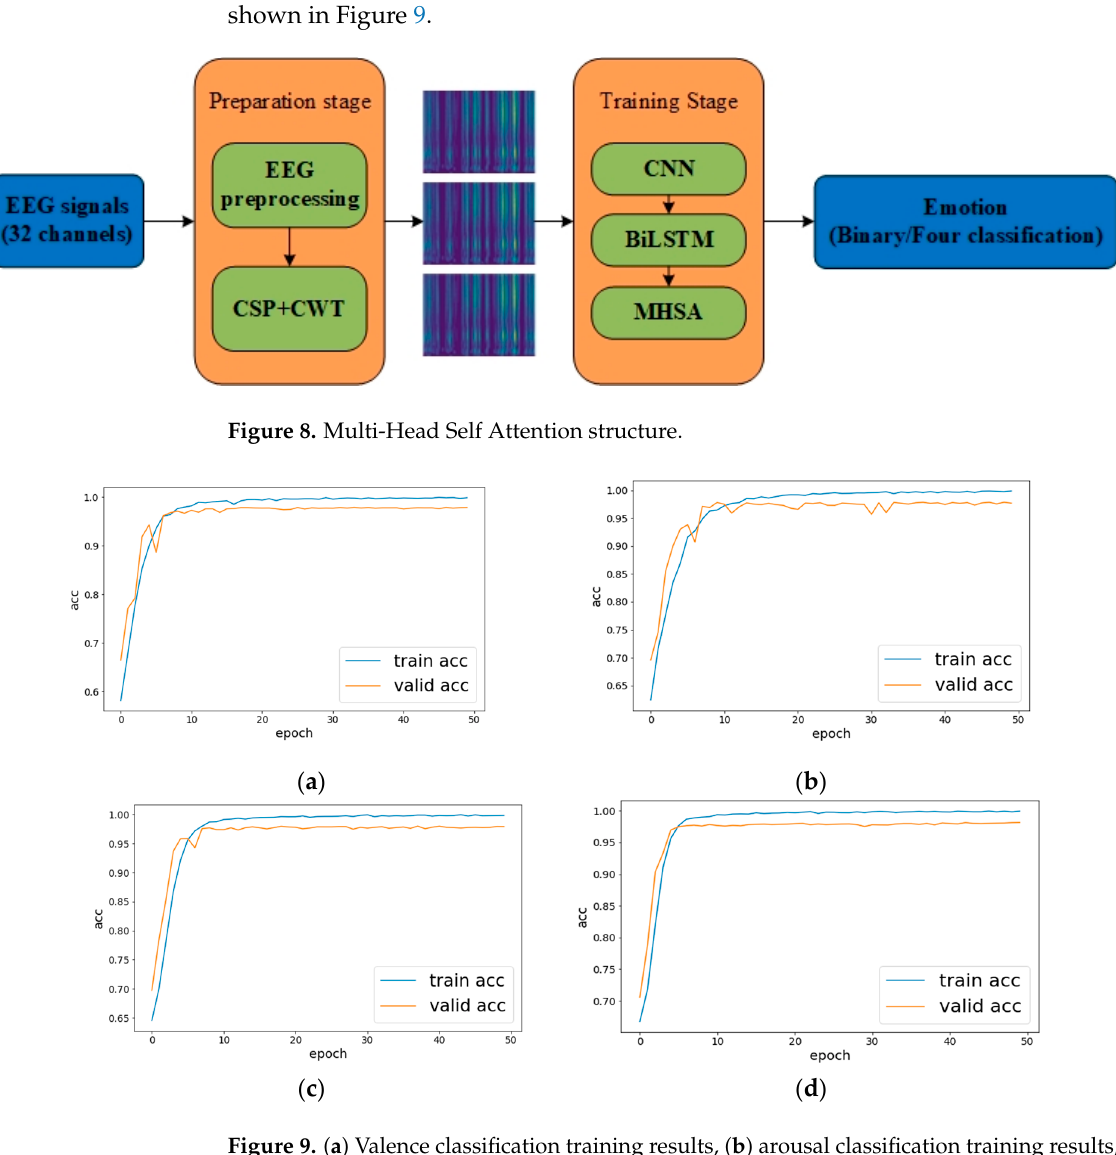
Figure 9. ( a ) Valence classification training results, ( b ) arousal classification training results, ( c ) dom- inance classification training results, ( d ) liking classification training results.